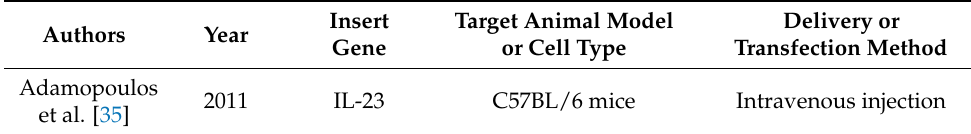
Table 2. List of arthritis induction study using minicircle